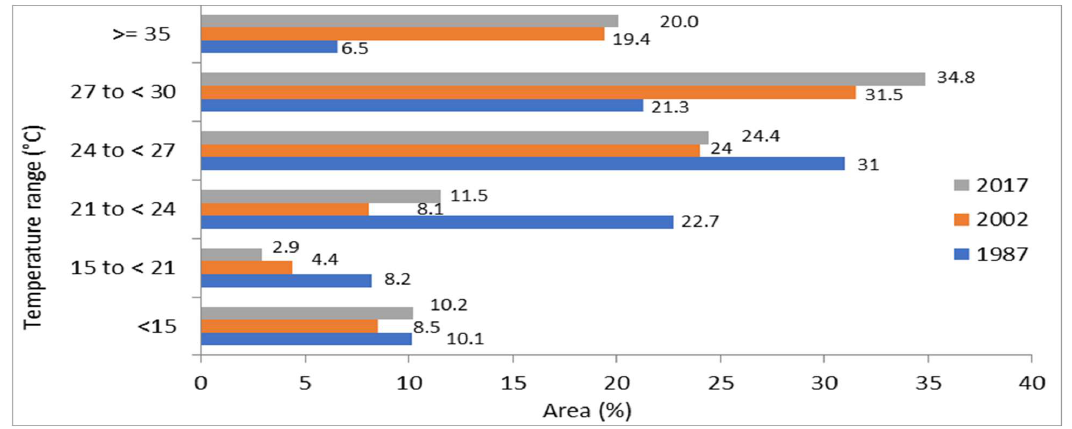
Figure 6. Distribution of different temperature ranges in area km 2 for the years 1987, 2002 and 2017.